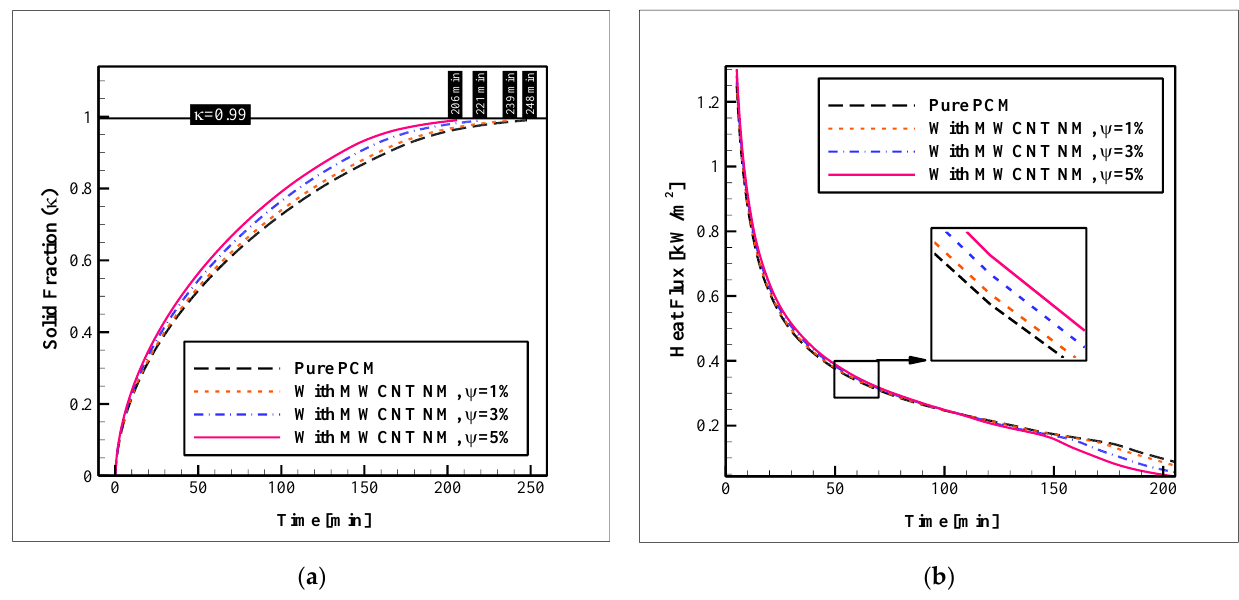
Figure 11. The effects of various volumetric concentrations of the optimal NM type (MWCNT) on ( a ) progression of the average solid fraction; and ( b ) the heat flux passing through the refrigerant tubes. By comparing these values to that of the benchmark model (690 min), it can be comprehended that the combination of the plate-fin network as well as MWCNT NMs with volume fractions of 1, 3, and 5% can improve the overall solidification process by 65.36, 67.97, and 70.14%, respectively, which are significant improvements.